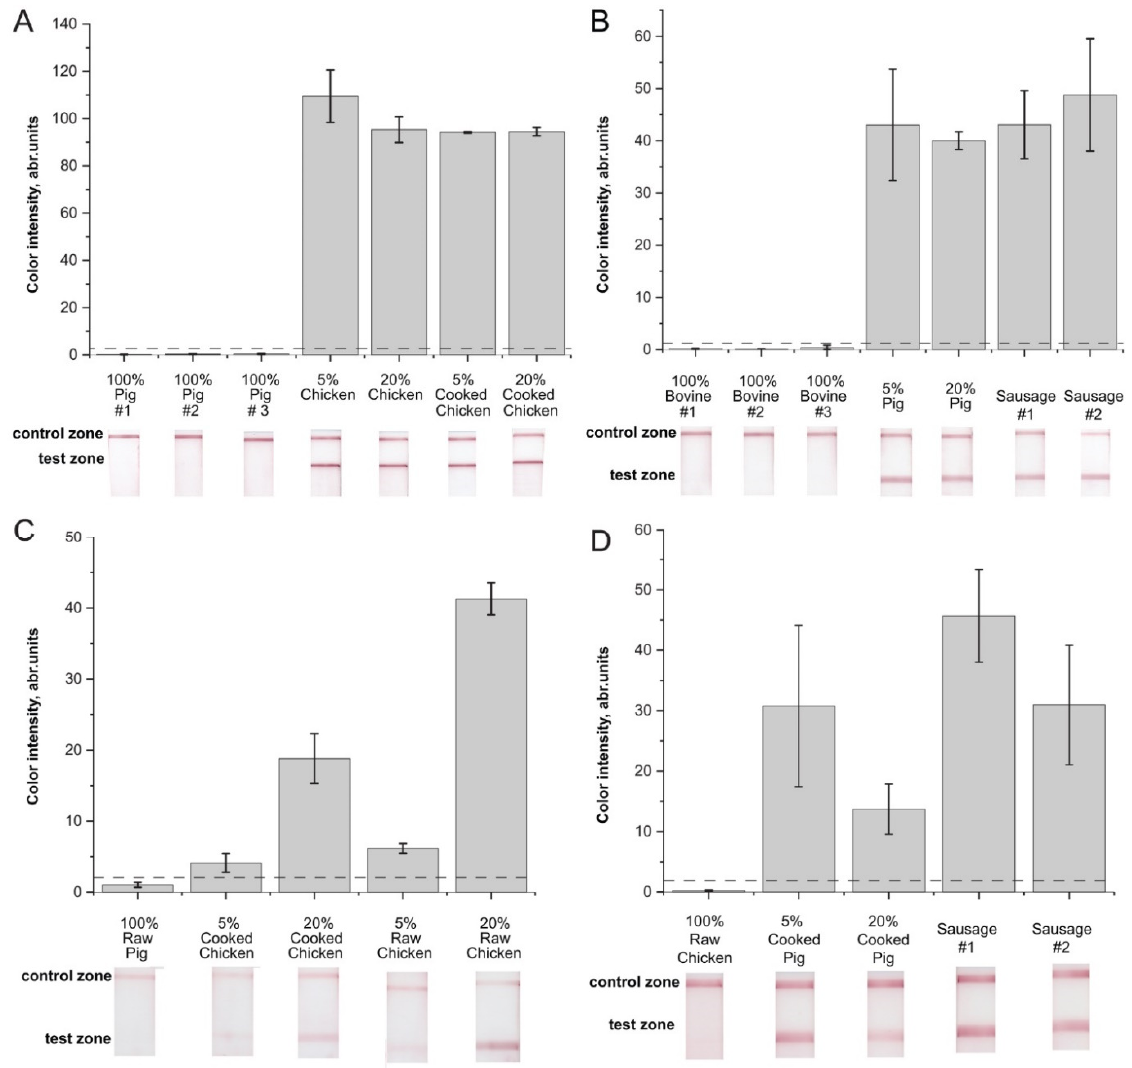
Figure 5. RPA–LFA of meat samples. ( A ). Detection of chicken meat in samples after accurate DNA extraction. ( B ). Detection of pig meat in samples after accurate DNA extraction. ( C ). Detection of chicken meat in samples after rapid DNA extraction. ( D ). Detection of pig meat in samples after rapid DNA extraction. Number of repeats: 2. The dashed line represents the signal visible to the naked eye (2